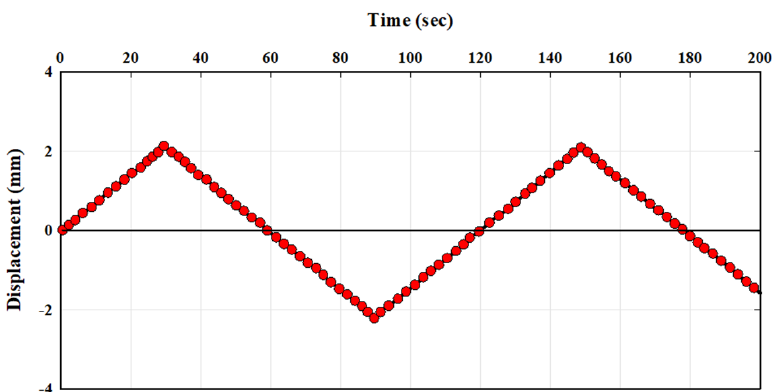
Figure 7. Characterization of the applied displacement cycles to the top of the wall.